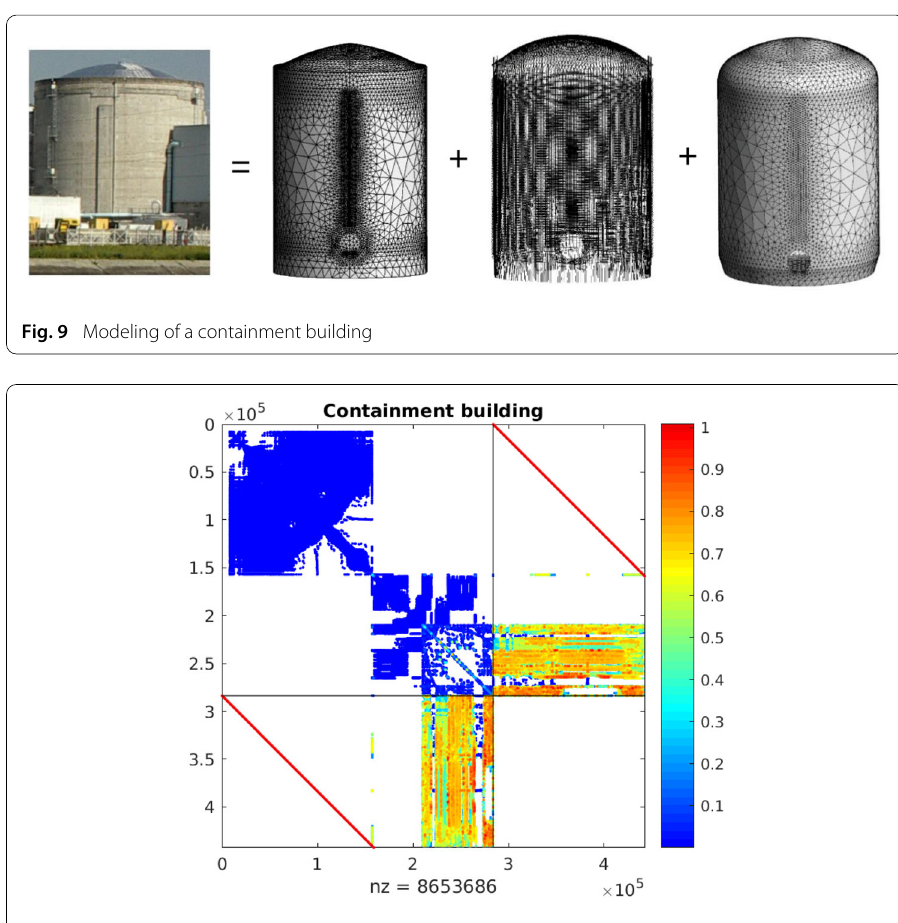
Fig. 10 Saddle point system after permutation and